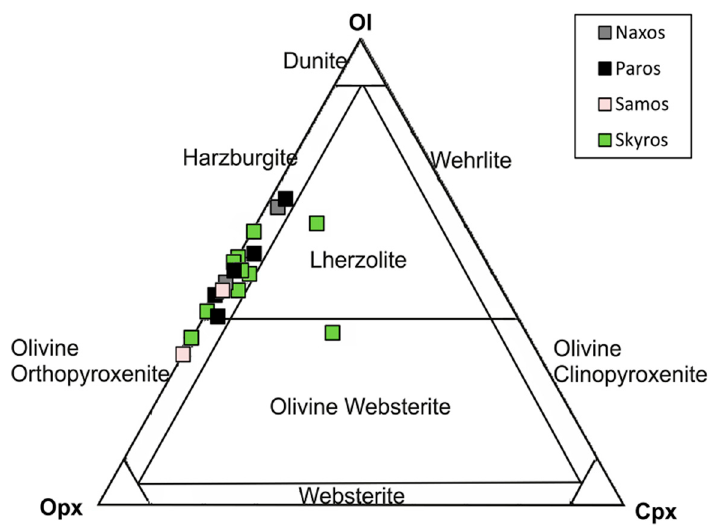
Figure 8. Spinel peridotite norm compositions of the ultramafic rocks from the Cyclades and Skyros plotted on the ultramafic classification diagram of IUGS.